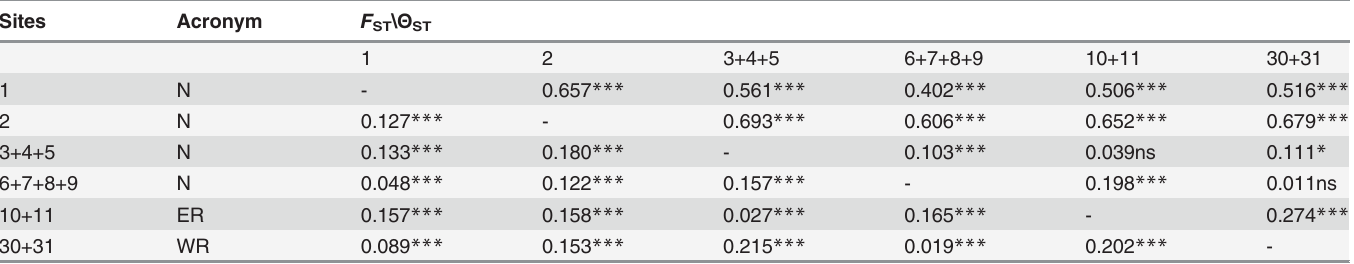
For mtDNA, ER and WR in Poland, i.e. fronts, are not differentiated from their respective pu- tative sources in the native region, i.e. Dnieper (3+4+5) and Danube (6+7+8+9), respectively (Table 3), while differentiation between fronts was significant (Table 3). For msat, although all pairwise comparisons for differentiation were significant (Table 3), the level of differentiation between fronts in Poland and their respective putative areas of origin was low ( F = 0.019) compared to differentiation among sites belonging to different routes (0.157 < F 0.215) (Table 3). Bayesian clustering analysis showed clearly, that individuals from the western front (Poland), the western route and the source in Danube from a homogeneous genetic unit, while the eastern front with its putative source in Dnieper form another homogeneous genetic unit (Fig. 4A,B).